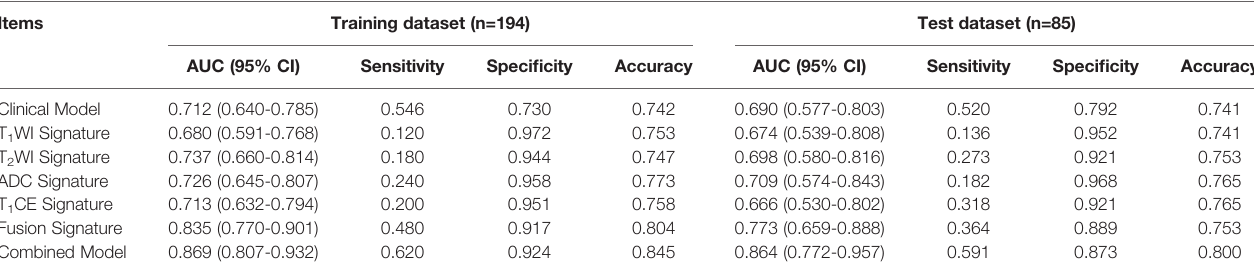
TABLE 4 | Predictive performance of different models.